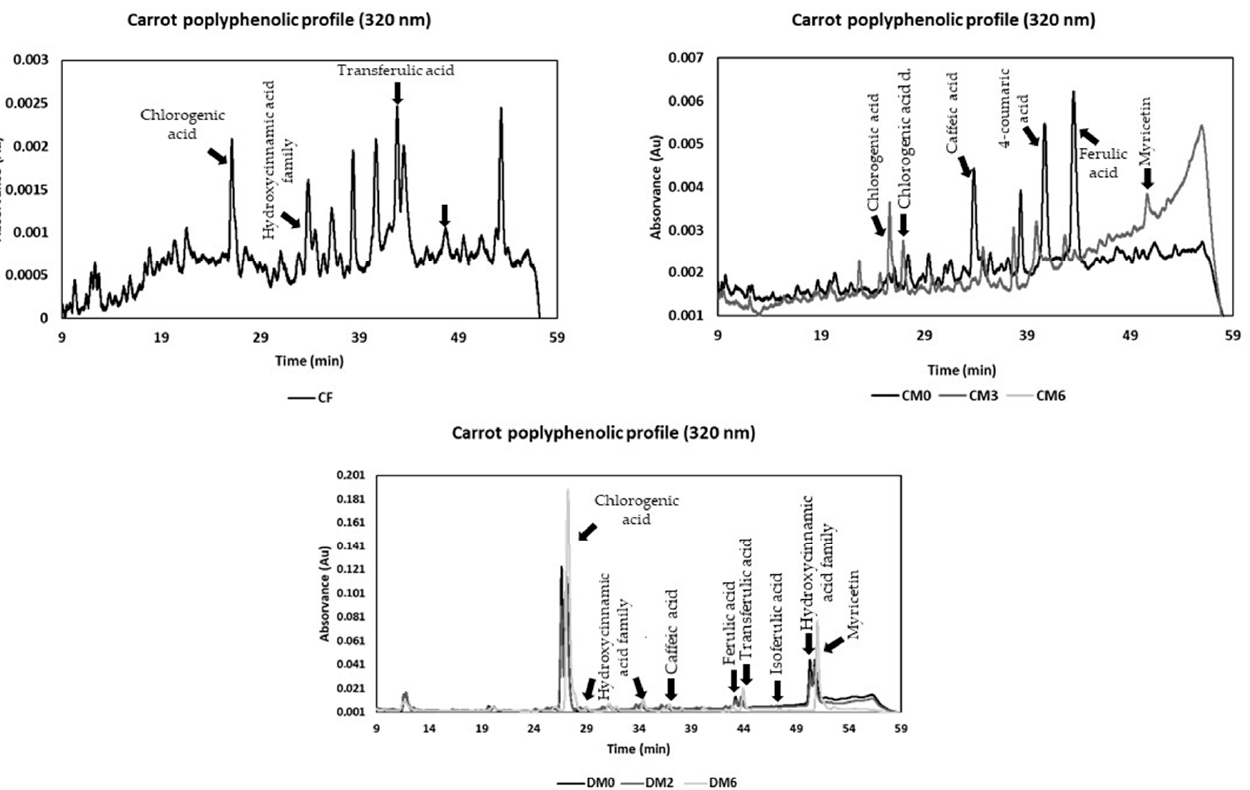
Figure 3. Chromatograms of identified free phenolic compounds of ( a ). fresh carrot by-products and during ( b ). the pulps freezing and ( c ). drying storage of powders at a wavelength of 320 nm. CF = fresh carrot. CM0 = 24 h after the freezing storage of carrot pulp. CM3 and CM6 = month three and six of the freezing storage of carrot pulps, respectively. DM0 = day 0 of the carrot powders storage. DM2 and DM6 = month two and six of the storage period of carrot powders.